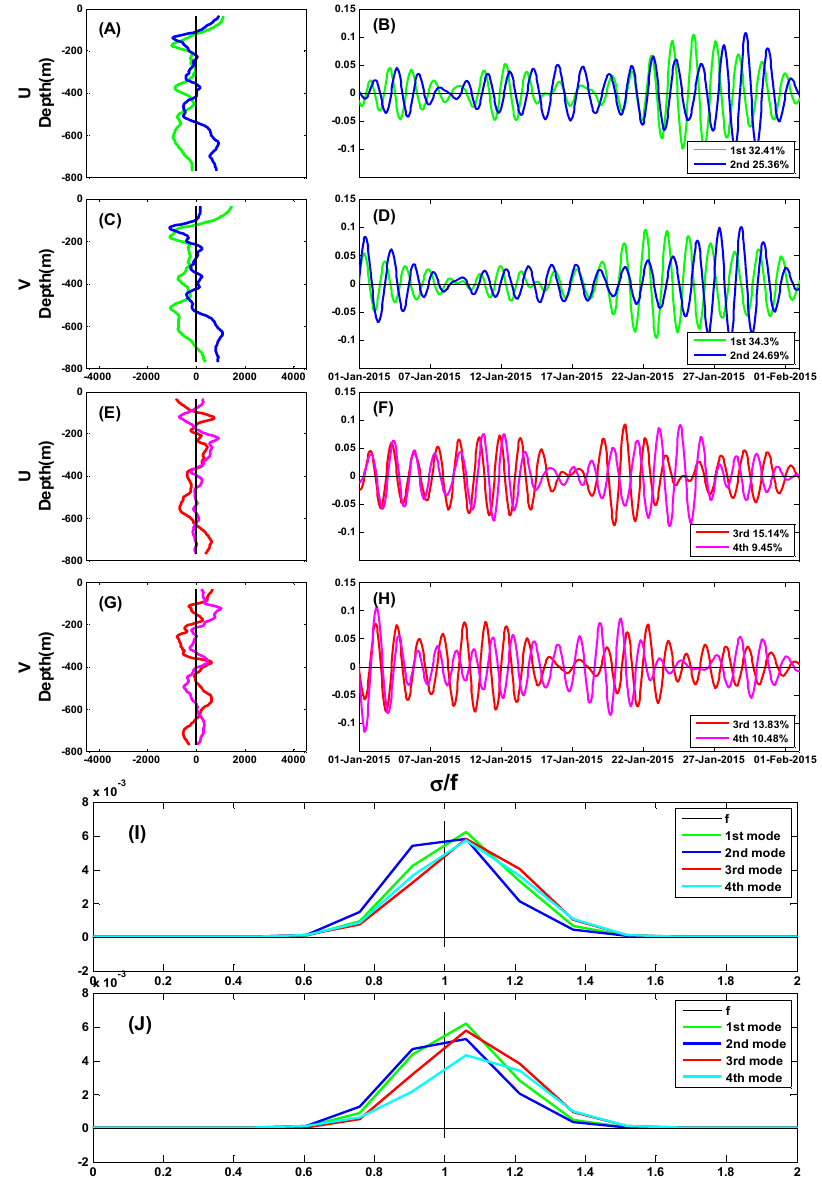
Figure 12. Vertical profiles of the ( A and E ) eastward and ( C and G ) northward components of the near-inertial current and the corresponding ( B and F ) eastward and ( D and H ) northward time series by empirical orthogonal function (EOF) analysis. The first and second modes are shown in A , B , C , and D . Meanwhile, the third and fourth modes are shown in E , F , G , and H . Power spectra of the ( I ) eastward and ( J ) northward time series of the near-inertial currents in the three NIOs by EOF analyses result. The horizontal axis of the figure is the relative frequency of the Coriolis frequency f . The vertical axis is spectral density with the unit m 2 s − 2 cpd − 1 . I and J have the time series results of the first four modes by EOF analyses. The NIO signal occurred in January 2015.